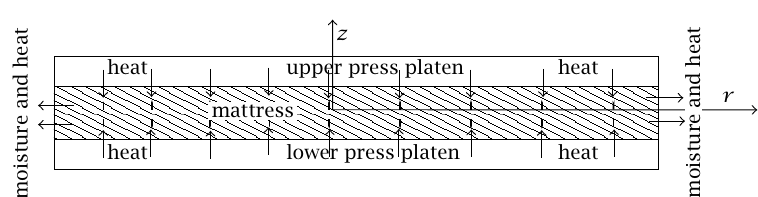
Figure 1.1 . Hot pressing process